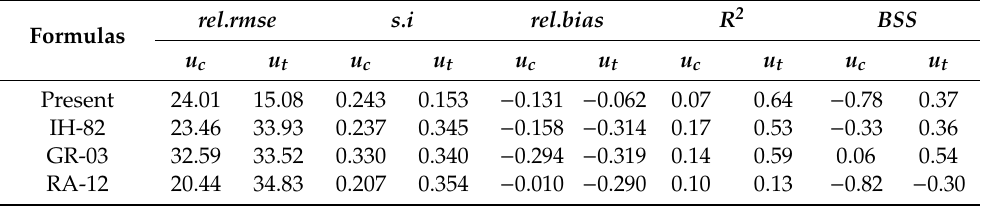
Figure 12. Comparison between computed peak onshore ( a ) and peak offshore ( b ) orbital velocity obtained by the studied formulas and measurements for Test 1A, 1B, and 1C. Table 5. Quantitative assessment of formula performances for the LIP11D data.